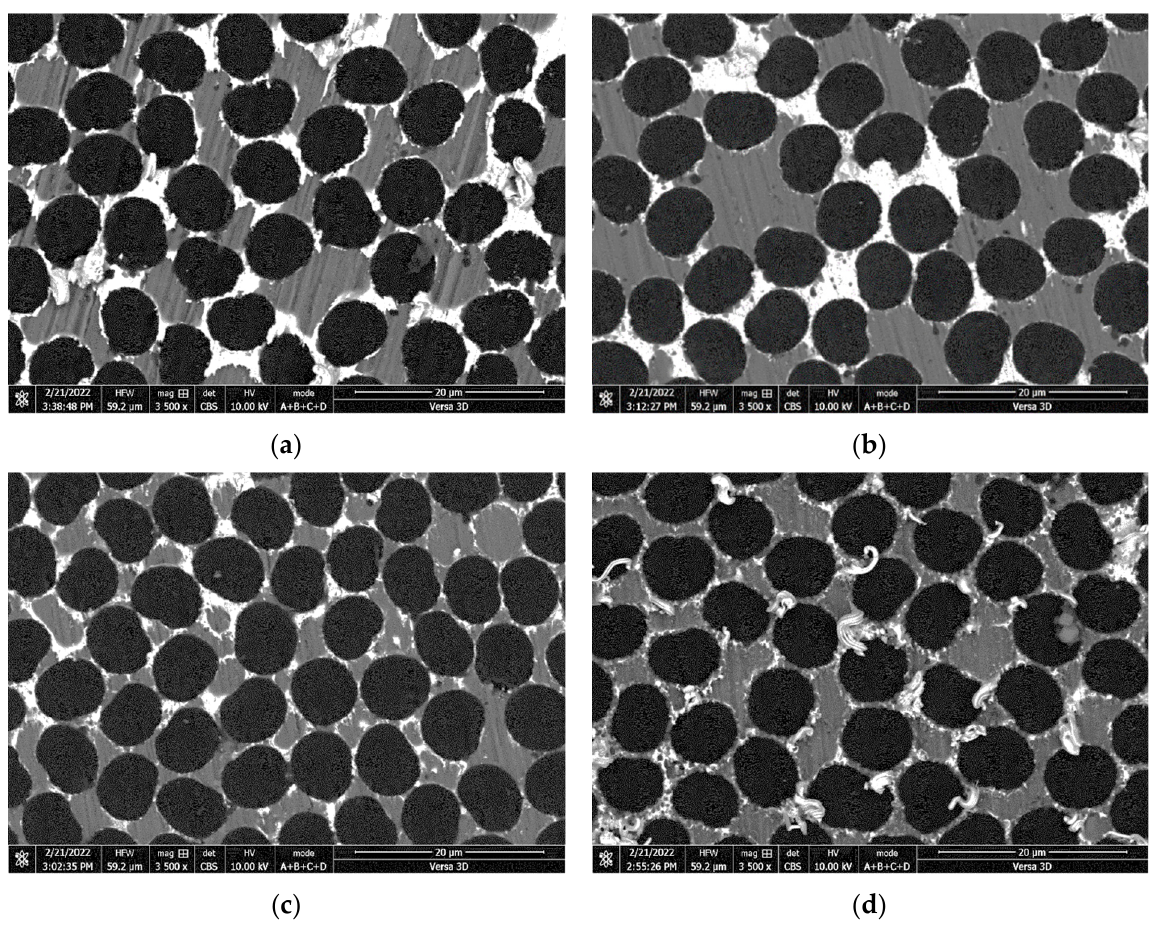
Figure 1. Microstructure of the composite wire in an initial state ( a ) and after heat treatment for 5 min at 500 °C ( b ), 550 °C ( c ), and 600 ° C ( d ).